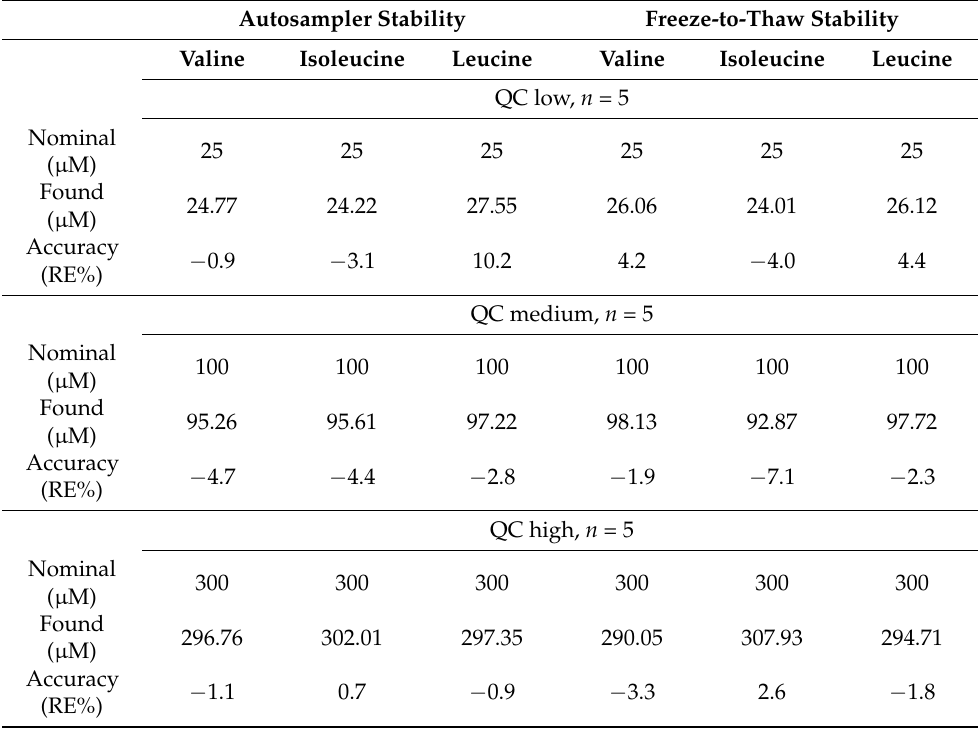
Table 9. Stability testing of valine, leucine, and isoleucine in QC